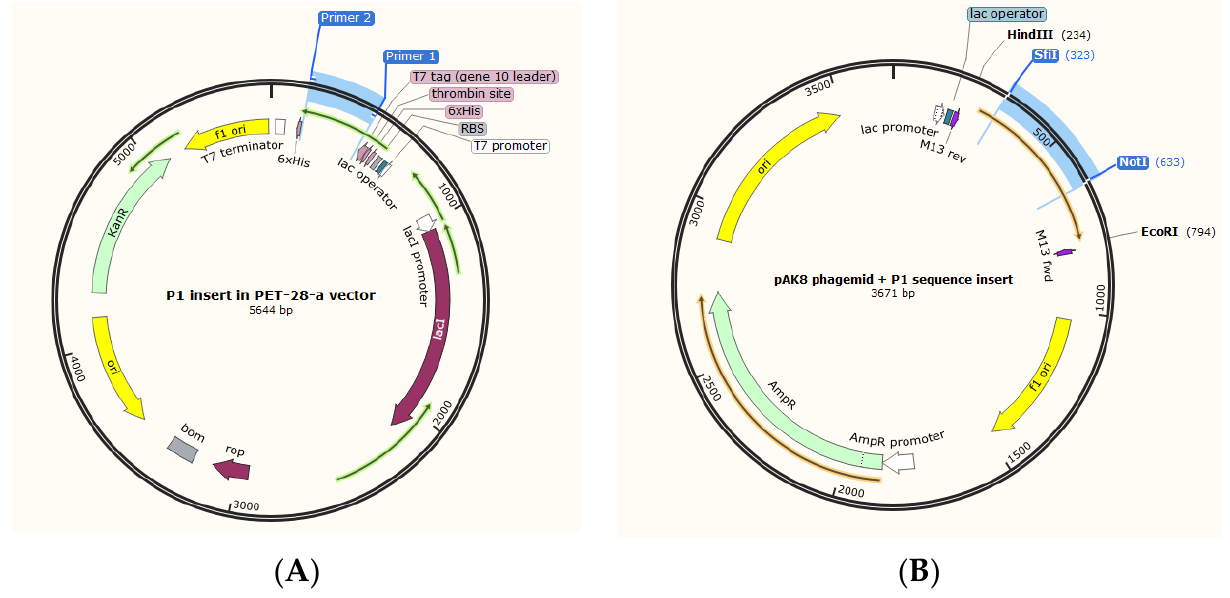
Figure 1. Subcloning of the P1-encoding nucleotide sequence from the PET-28-a to the pAK8 phagemid. ( A ): PET-28-a-P1 vector map. The P1-encoding gene was amplified by PCR using primers with SfiI and NotI restriction enzyme overhangs. ( B ): Map of pAK8-P1 phagemid. Insertion of the amplified gene into the pAK8 phagemid with SfiI and NotI restriction sites. Maps were generated using SnapGene 5.3.1 software.